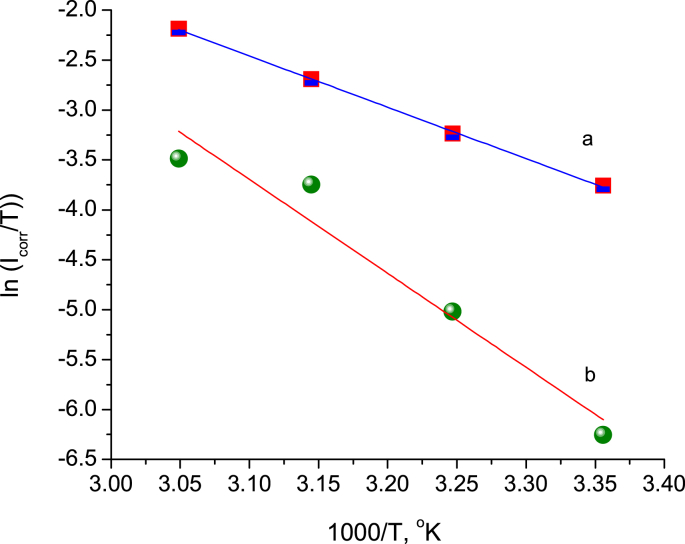
Transition state plots for free H2SO4 a) without and b) with 1 mM of BQYP molecules.